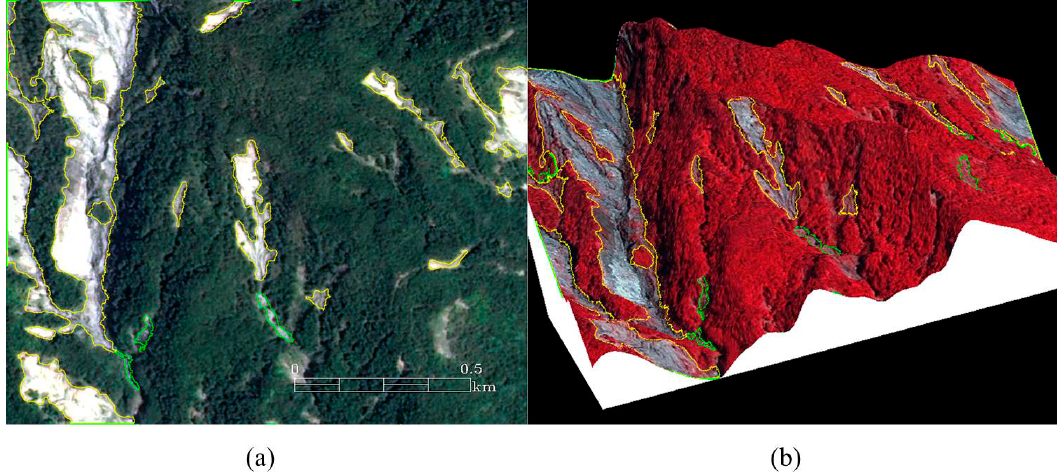
Figure 3. Detecting landslides from Formosat ‐ 2 satellite images by ELSADS: ( a ) 2D true ‐ color composite image; and ( b ) Standard false ‐ color composite image overlaid on the corresponding DEM.